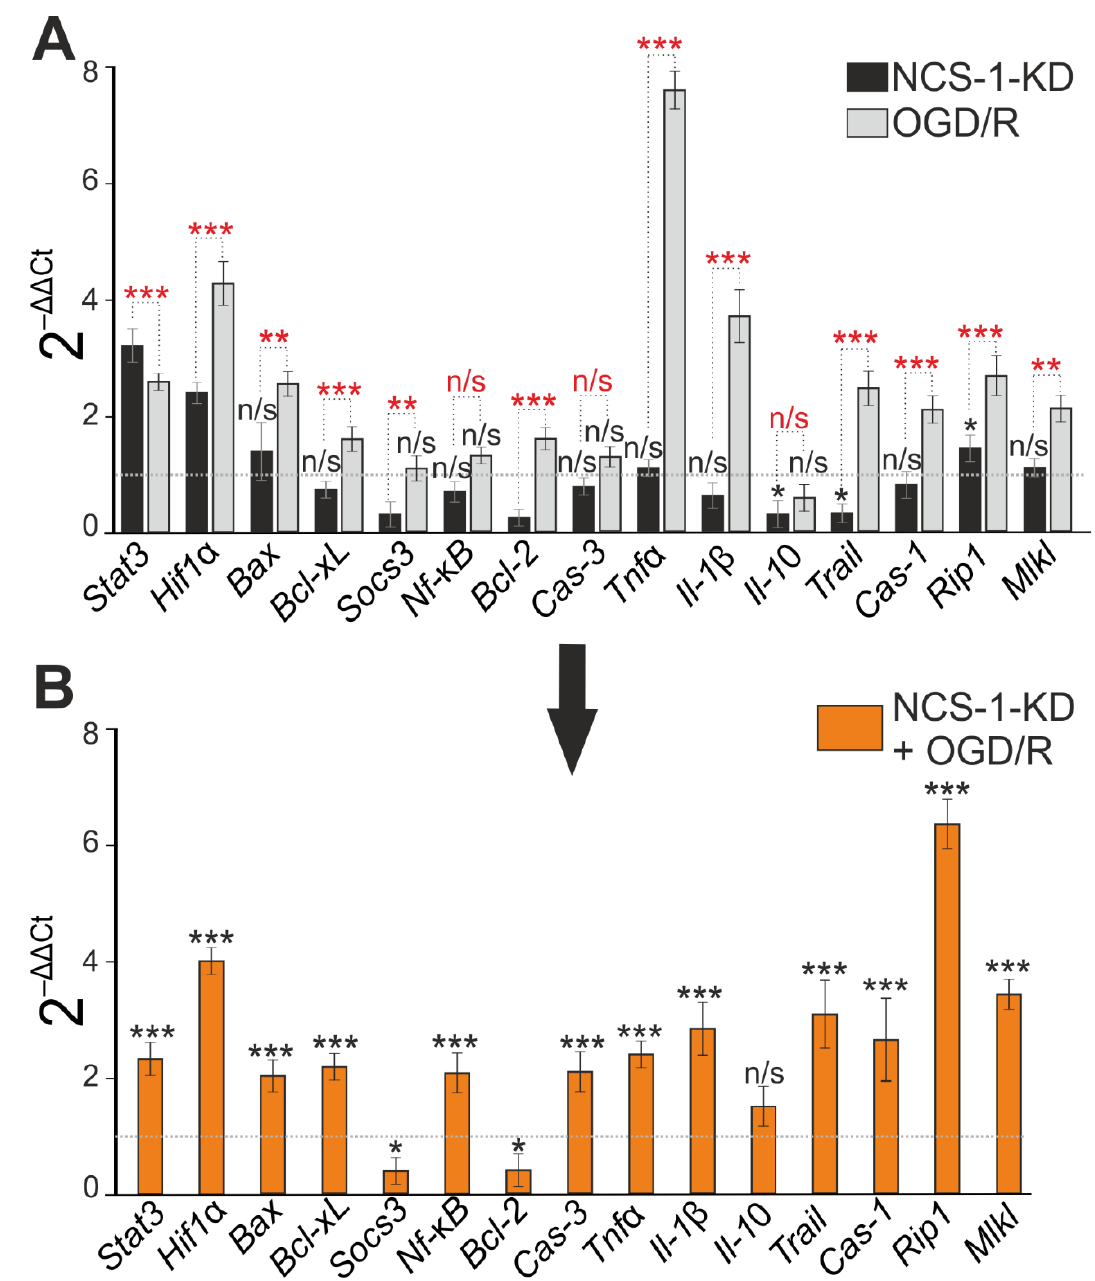
Figure 4. Effect of NCS-1-KD and OGD/R on mRNA expression of proteins regulating apoptosis, necrosis, and inflammation. ( A ) Baseline mRNA expression in NCS-1-KD cortical cells (black bars) and cortical cells (Scra) 24 h after OGD/R. Dashed line level of gene expression in control (Scra without NCS-1-KD and OGD/R). ( B ) Effect of NCS-1-KD on OGD/R induced gene expression. Dashed line level of gene expression in OGD/R experimental group (Scra without NCS-1-KD). Statistical significance was assessed using unpaired t -test. n/s — data not significant ( p > 0.05), * p < 0.05, ** p < 0.01, and *** p < 0.001. Comparison between experimental group NCS-1-KD and experimental group OGD/R is marked by red asterisks. In panel ( A ), columns without black asterisks — differences are significant *** p < 0.001. The number of samples is 4. N (number of animals used for cell cultures preparation) = 4.